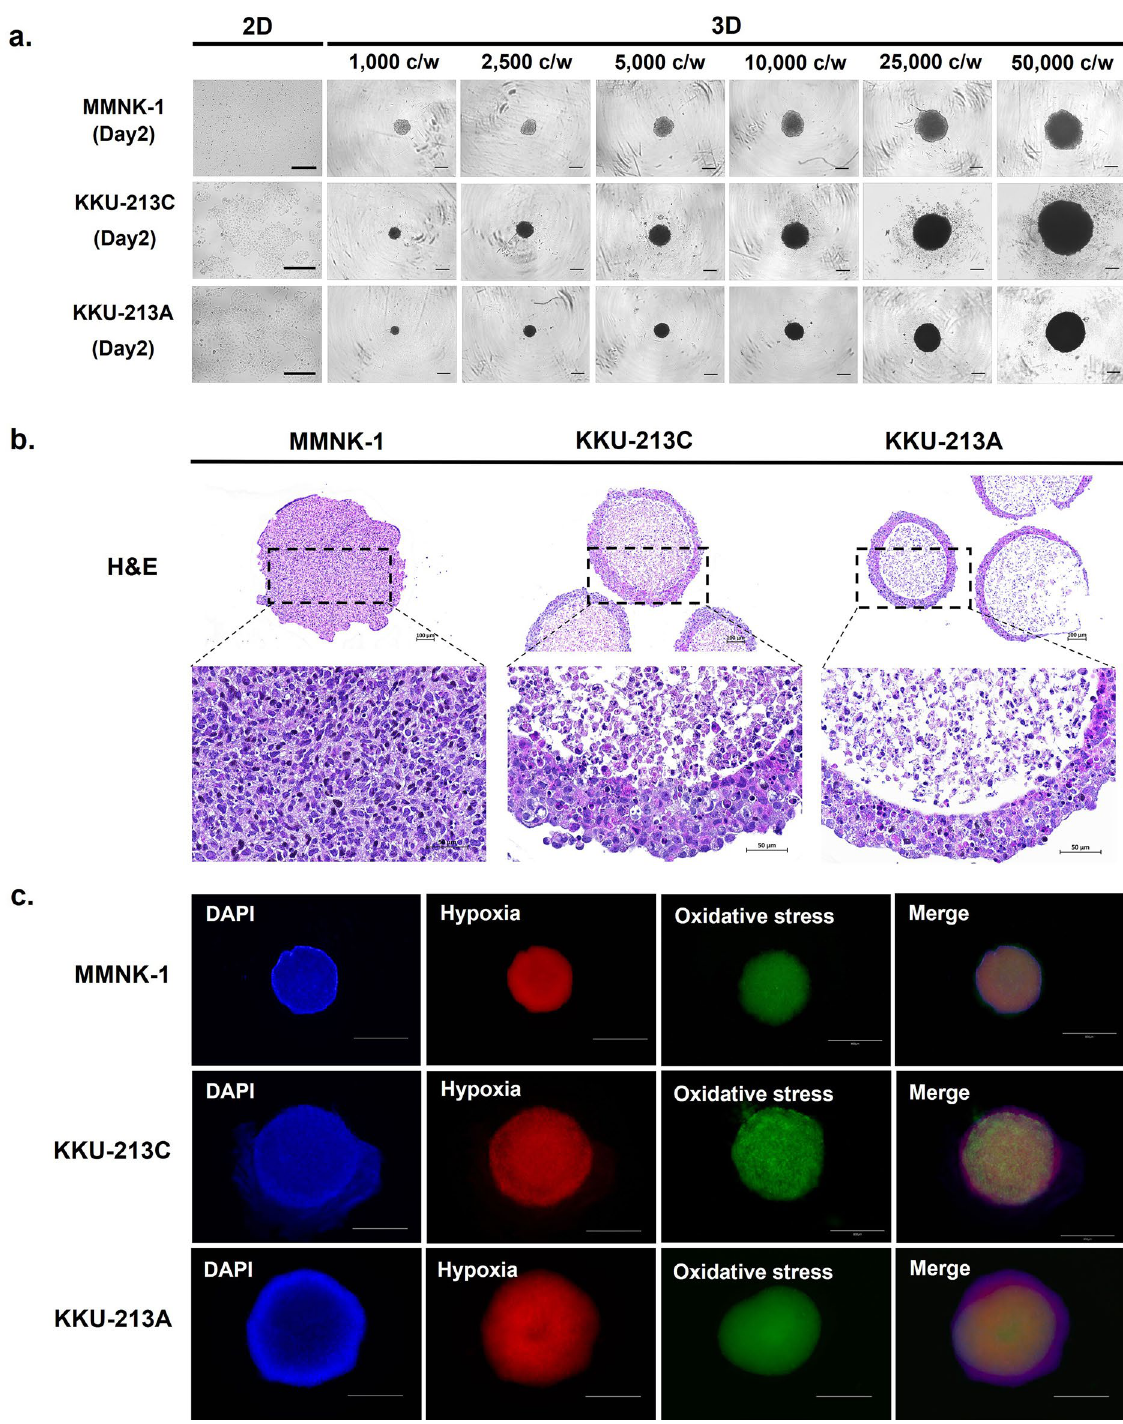
Figure 2. Characterization of 3D MCSs. ( a ) CCA and cholangiocyte cell lines were varied with seeding numbers (1,000 2,500 5,000 10,000 25,000 and 50,000 cells per well) and cultured for 48 h to observe the MCS aggregation under an inverted microscope. Scale bar represents 500 µm. ( b ) The 3D MCSs were embedded, sectioned, and stained with H&E. Scale bar represents 100 µm and 50 µm for zoom-in pictures. ( c ) The 3D MCSs exhibit typical zonation of hypoxia and oxidative stress determined by nuclei (DAPI, blue), Hypoxia probe (red), Oxidative stress probe (green). Scale bar represents 800